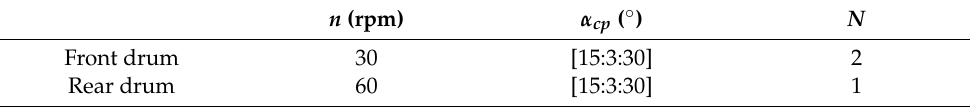
Table 3. The geometric parameter of variable helix angle.